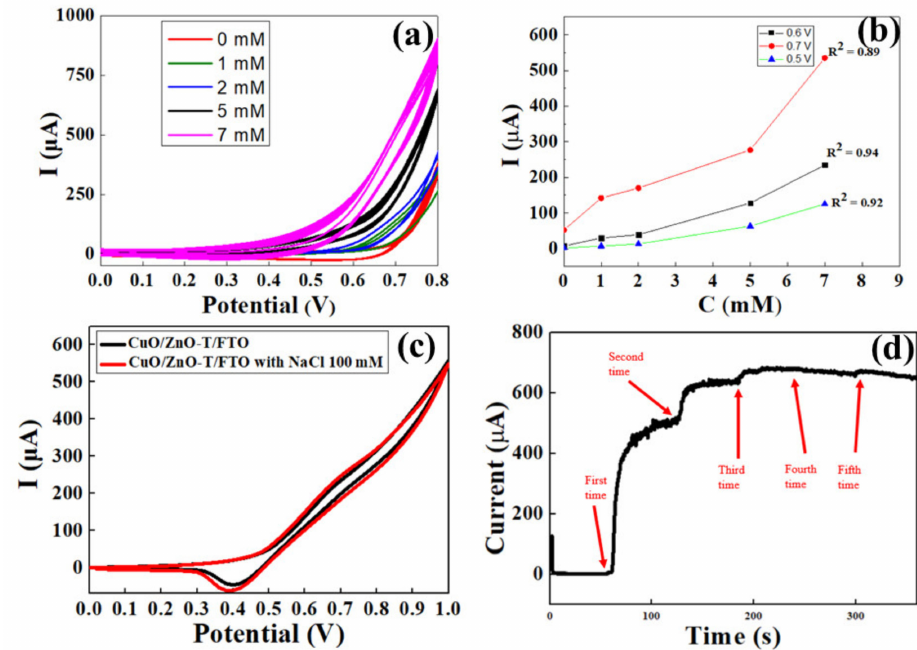
Figure 4. ( a ) CV curves in the presence of different glucose concentrations with a CZF-30 electrode (scan rate, 100 mV/s). ( b ) Corresponding calibration plot of peak current versus scan rate. ( c ) Re- sponses of the sensor to 5 mM glucose in 0.1 M NaOH solution with and without 100 mM NaCl. ( d ) Responses of the sensor in 0.1 M NaOH with the successive addition of 5 individual doses of 5 mM glucose